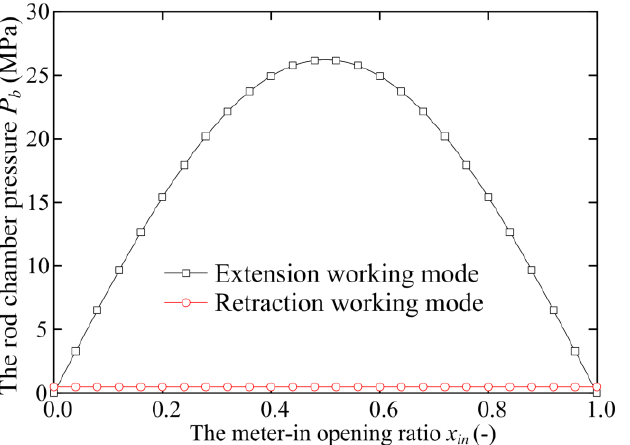
Figure 24. The variations of the rod chamber pressure P b of HPCIMS.